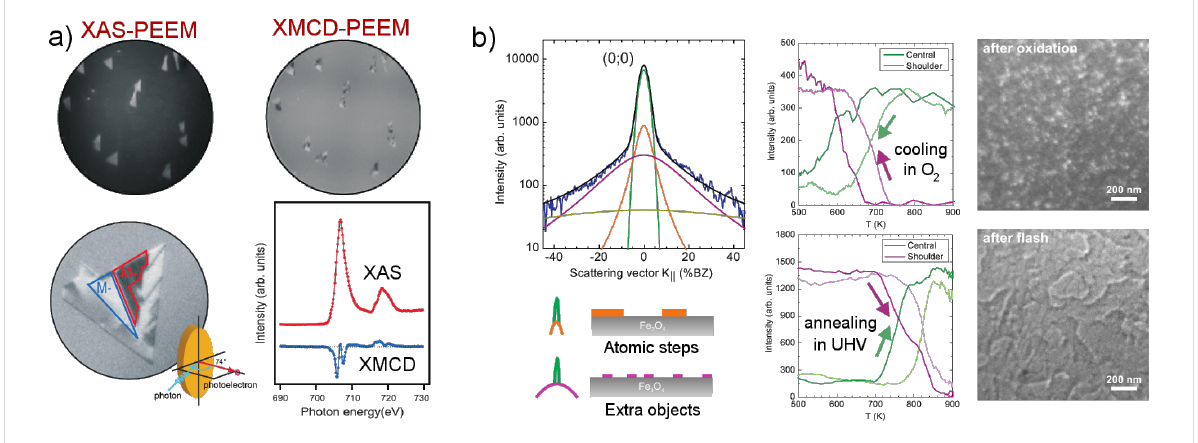
Figure 11: a) Magnetite islands and the FeO wetting layer on Ru(0001). Top panels show the island and magnetization distribution within a region of 30 μ m diameter, illuminated homogeneously by vertically scanning the photon beam during acquisition. Bottom panels show the details of the magnetic domains (left, field of view 4 μ m) and the Fe L 3 XMCD spectrum extracted from a single domain (right). (Reprinted with permission from [72]. Copyright 2012 American Physical Society.) b) Morphology of Fe 3 O 4 /Pt(111) from LEEM and μ -LEED spot profile analysis. The large tail in the (00) spot profile (seen on the left) is identified with the formation of oxygen-related agglomorates as sketched below. Middle panels show the effect of cooling/annealing on the spot profile. LEEM images on the right (at an energy of 24 eV) present the surface before and after the annealing cycle. (Reprinted with permission from [73]. Copyright 2012 American Physical